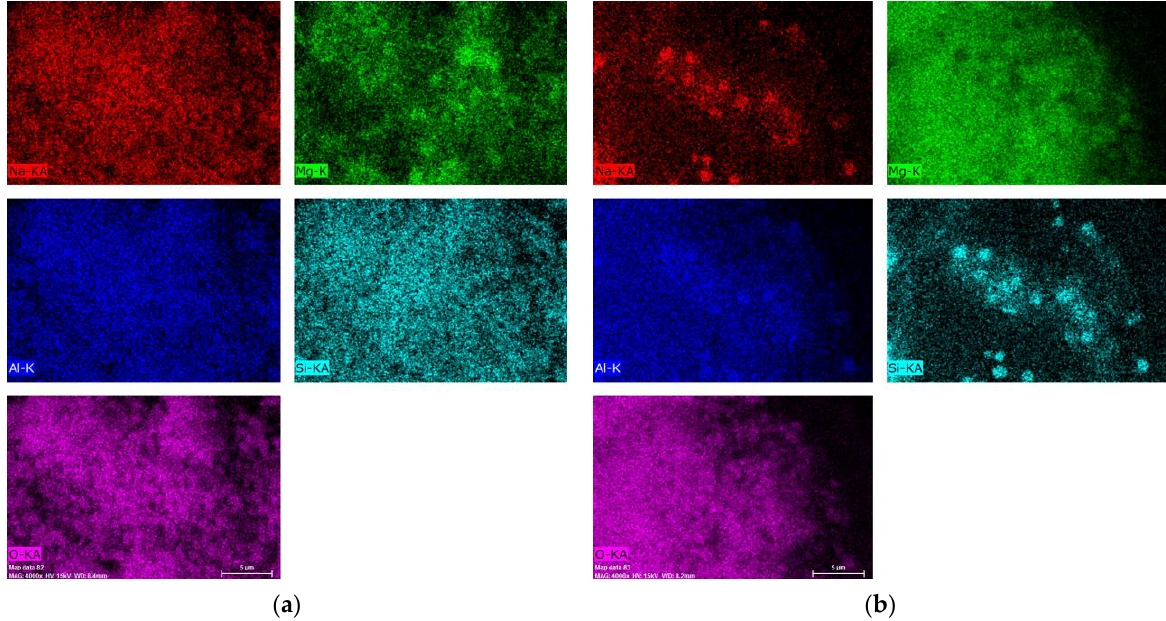
Figure 12. Physical mixture samples obtained after ( a ) calcination under He flow at 300 °C and ( b ) calcination under O 2 flow at 300 °C. Both samples underwent the rehydration process.